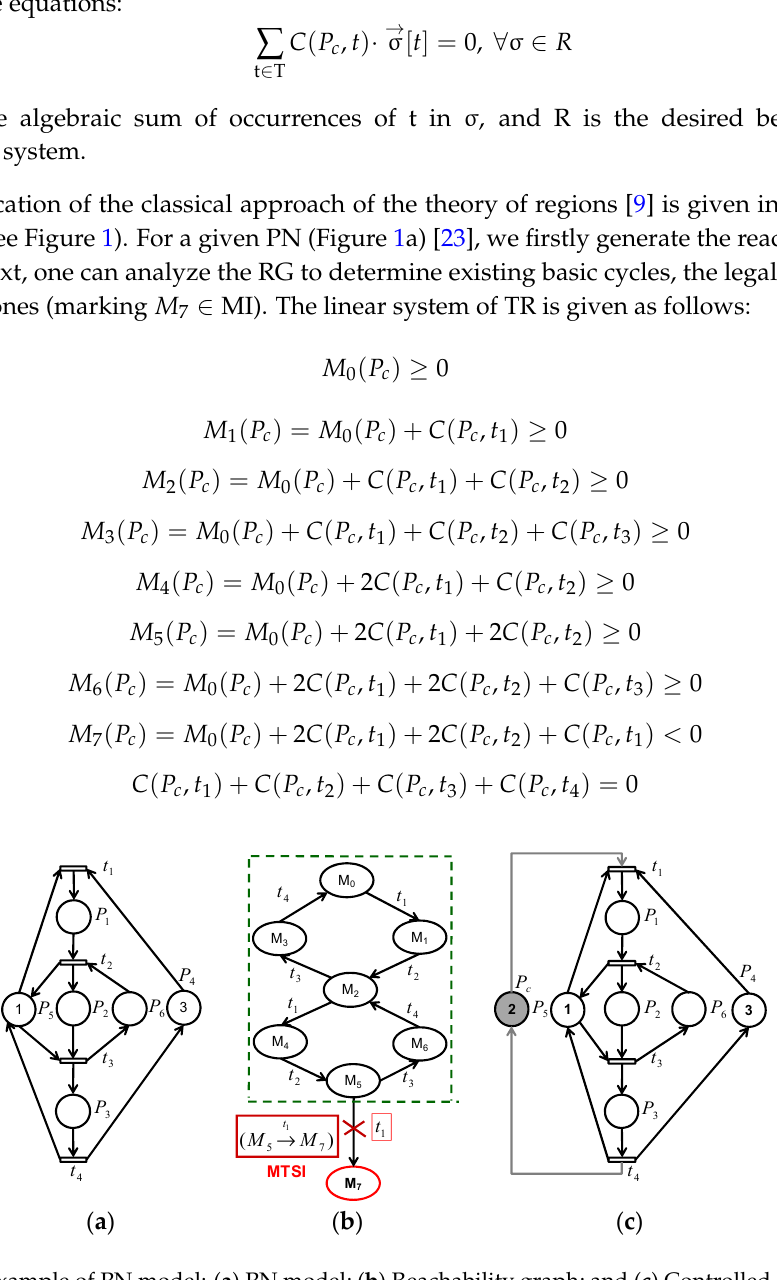
Figure 1. Example of PN model: ( a ) PN model; ( b ) Reachability graph; and ( c ) Controlled PN model.